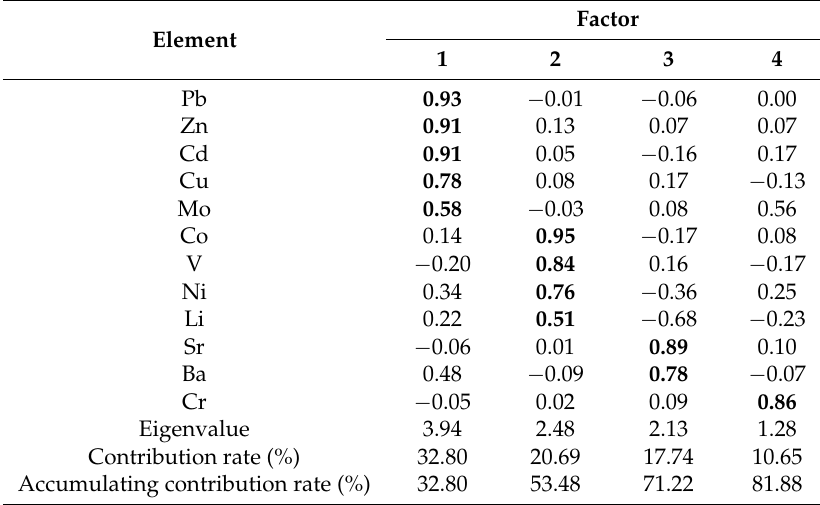
Table 6. Rotated component matrix of metals in the topsoil.